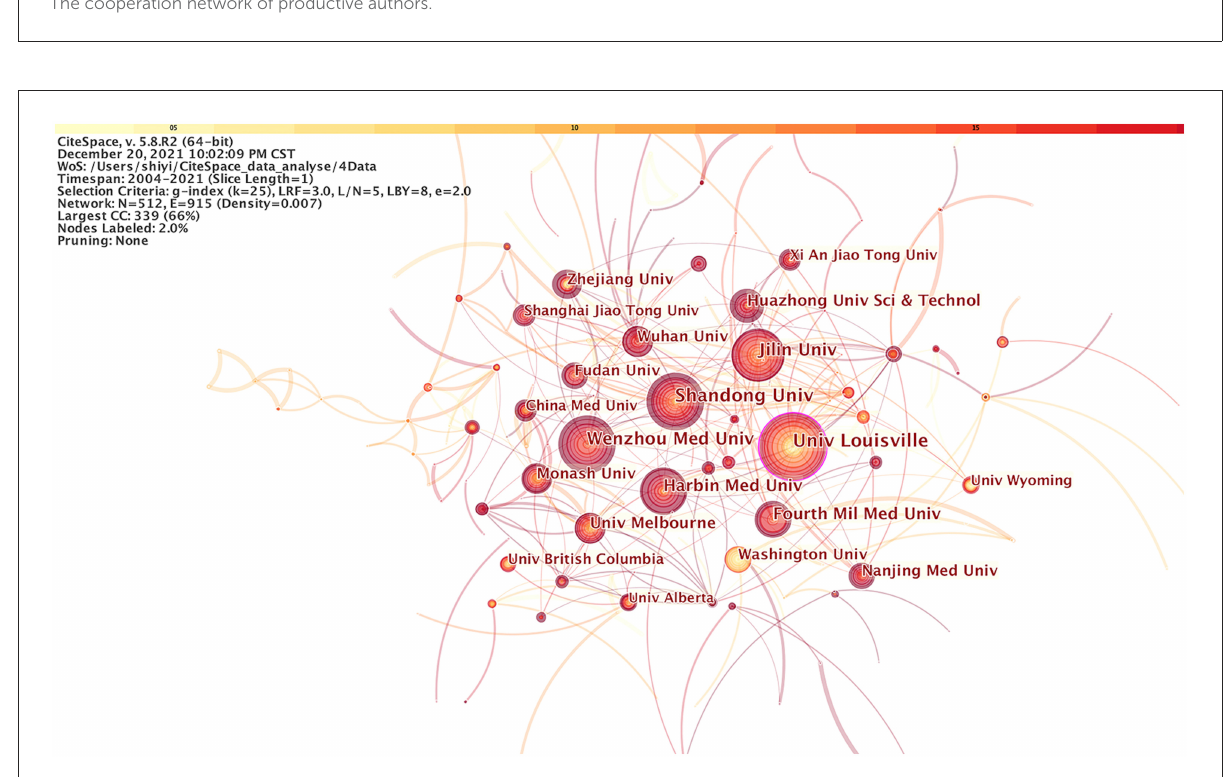
FIGURE3 The cooperation network of productive